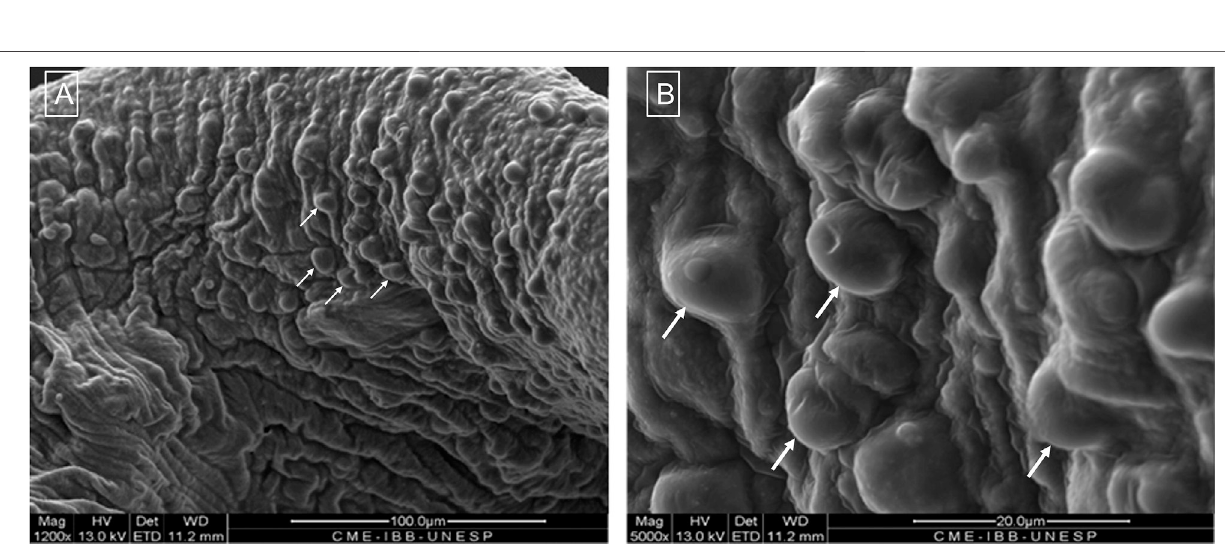
Frontiers in Bioengineering and Biotechnology |